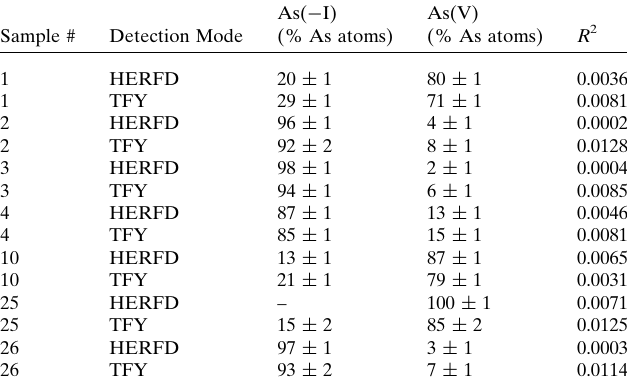
Table 3 LCF results for spectra from Long Lake mine tailings samples with a binary mixture of arsenopyrite and scorodite or kankite.